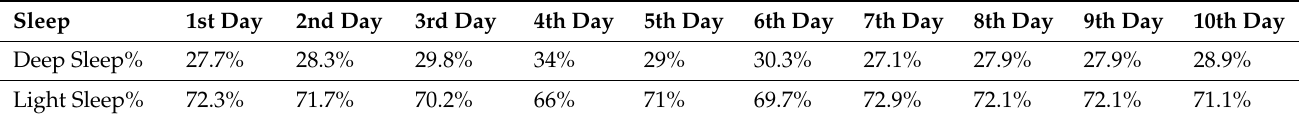
Table 6. Sleep quality